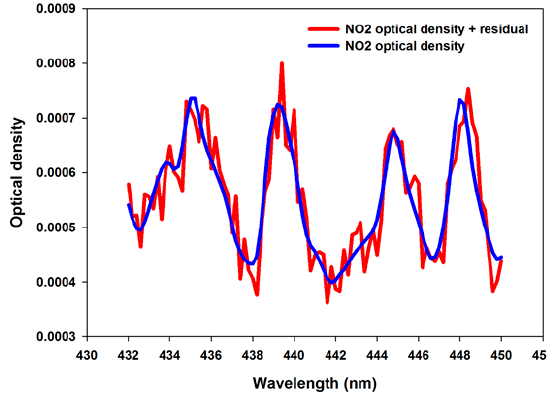
Figure 4. Example of spectral fit for NO 2 in the range 432 to 450 nm when NO 2 VCD is 1 × 10 15 mole cm − 2 , surface reflectance is 0.04, SZA and VZA are 20°, APH is 0 km, AOD is 0.1, and SSA is 0.999. The blue line is the NO 2 optical density (the cross section multiplied by the retrieved NO 2 slant column) and the red line is the blue line plus the fit residual. (Vertical column density (VCD), solar zenith angle (SZA), viewing zenith angle (VZA), aerosol peak height (APH), aerosol optical depth (AOD), single scattering albedo (SSA)).